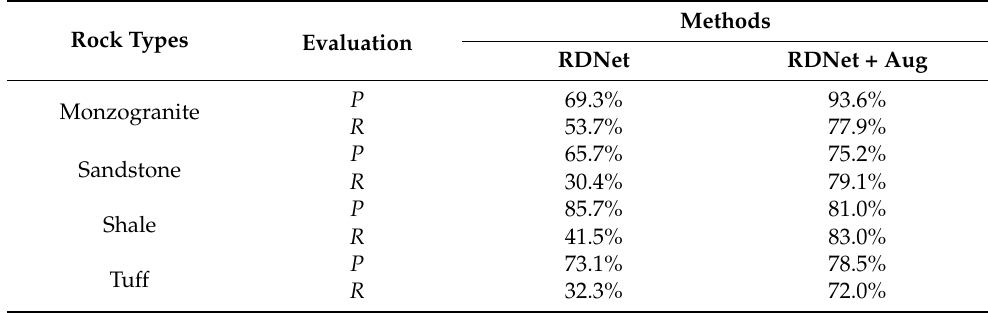
Table 8. The best model performance of RDNet and RDNet + Aug on four types rock lithology.